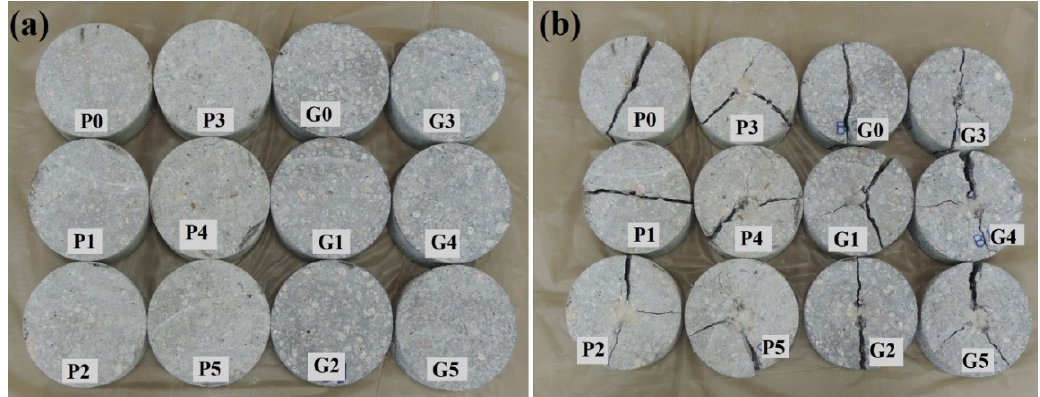
Figure 9. PAFRC specimens ( a ) before and ( b ) after impact load.